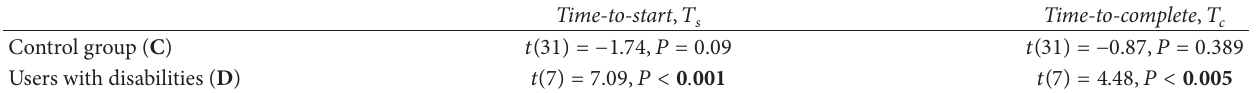
Table 3: Overview of the influence of mirror feedback as interaction feedback for each user group on the mean of the defined time measures.